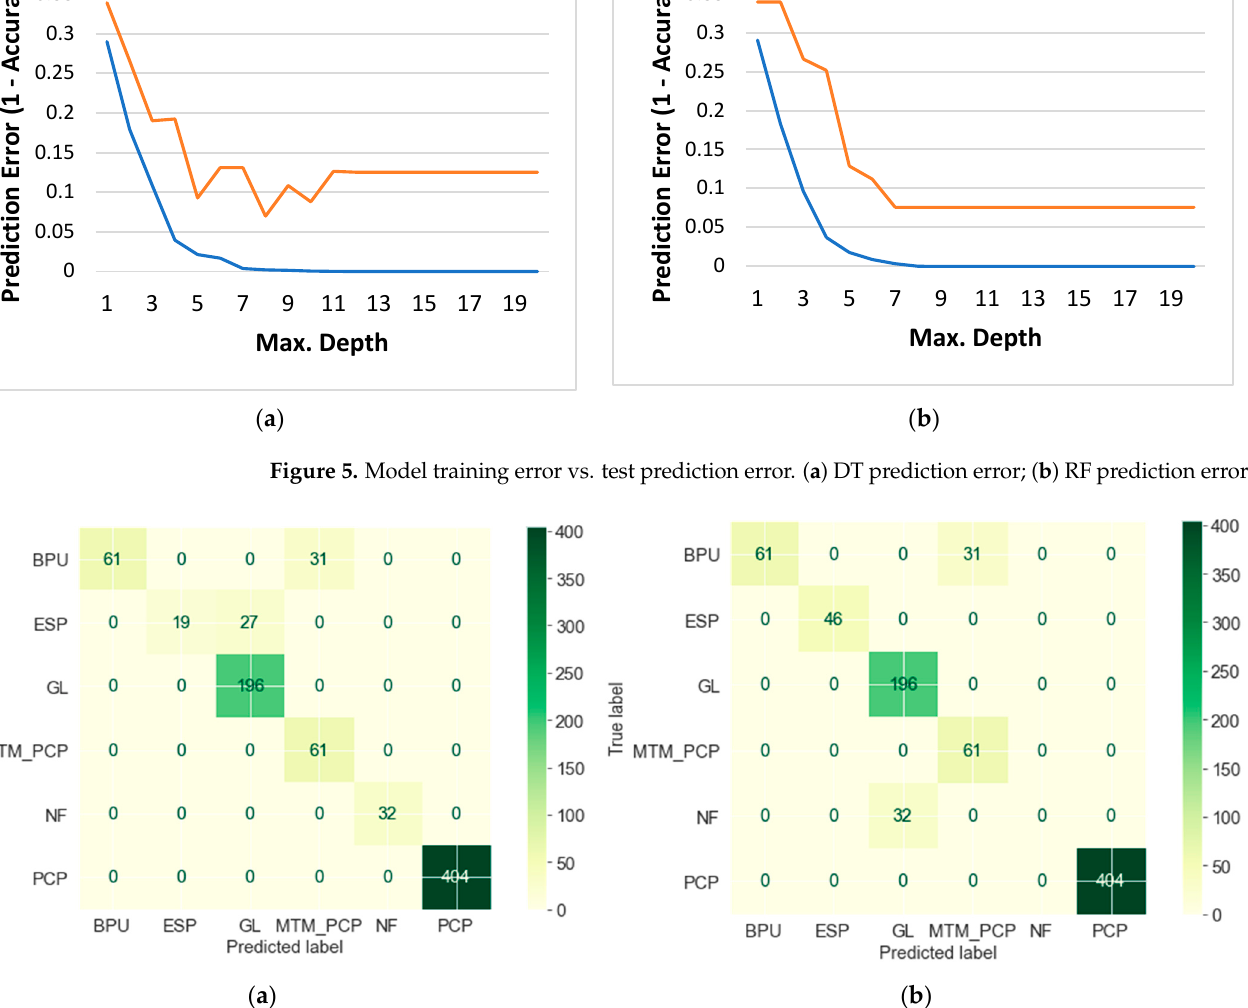
Figure 6. Classi fi cation report (confusion matrix) of actual AL in the fi eld and predicted AL by model. ( a ) DT confusion matrix (true label vs. predicted label); ( b ) RF confusion matrix (true label vs. predicted label). Table 3. AL selection results in comparison to a recent study using ML.